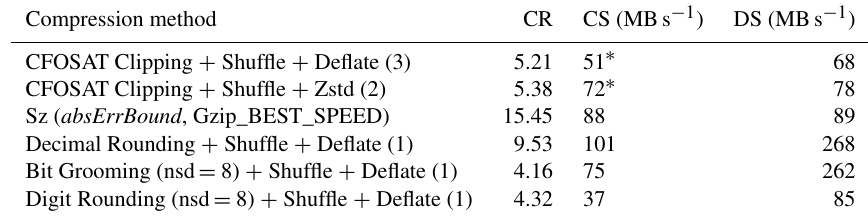
Table 9. Compression results for the CFOSAT L1A